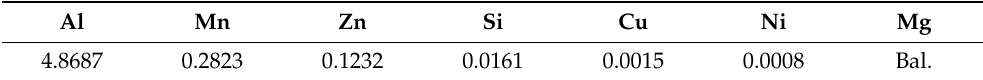
Table 1. Composition of the as-cast AM50 magnesium alloy